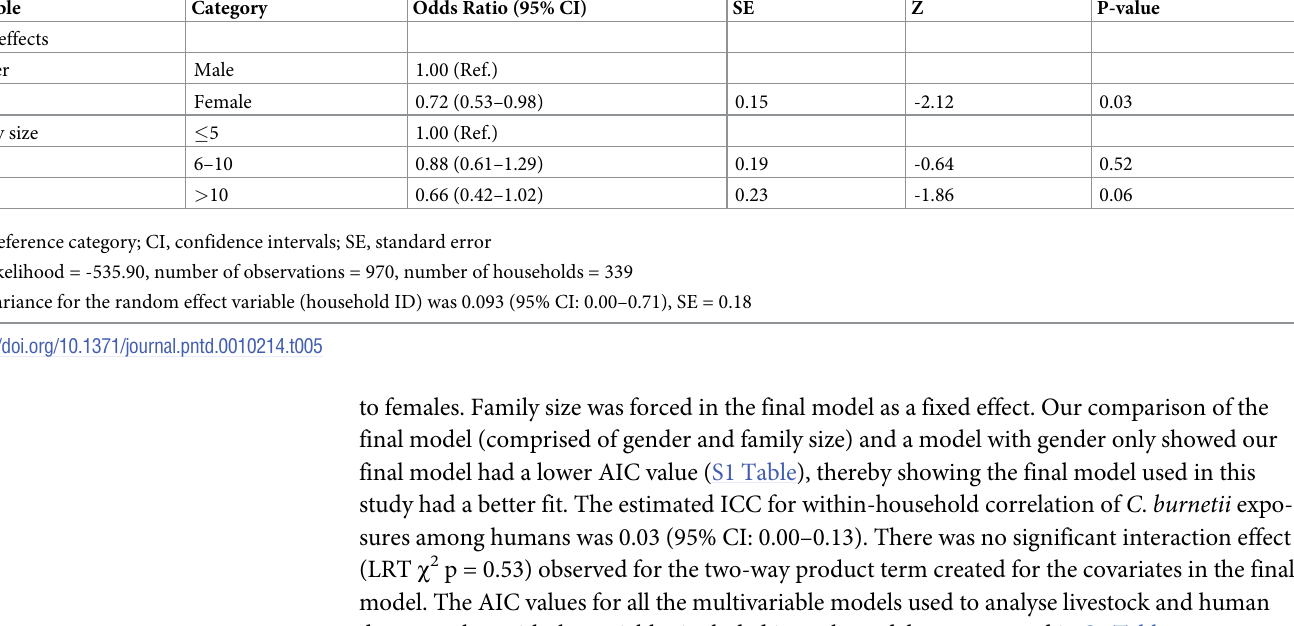
Table 5. Variables associated with C . burnetii seroprevalence in humans based on analysis using multivariable mixed-effects logistic regression model. Variable